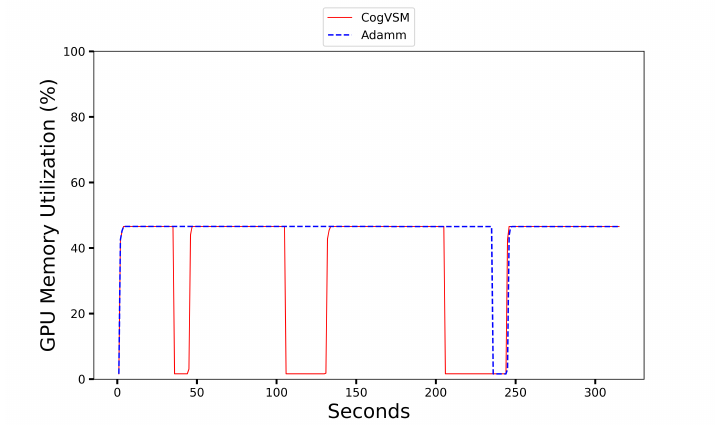
Figure 9. GPU memory utilization on an urban area video of the proposed CogVSM framework compared to the AdaMM framework ( θ m = 30 s for AdaMM).